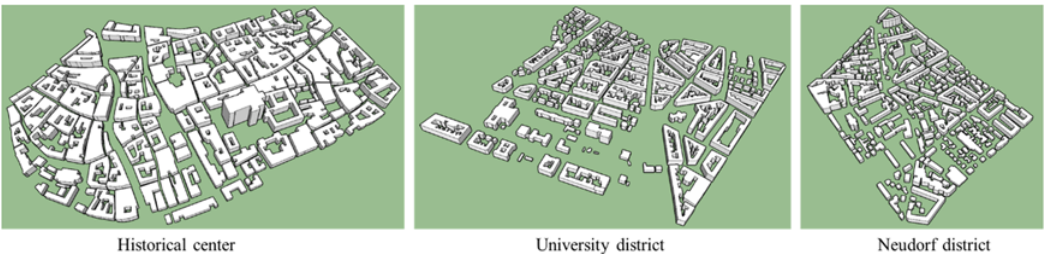
Figure 4. 3D datasets of the three districts derived from the BD Topo (IGN).